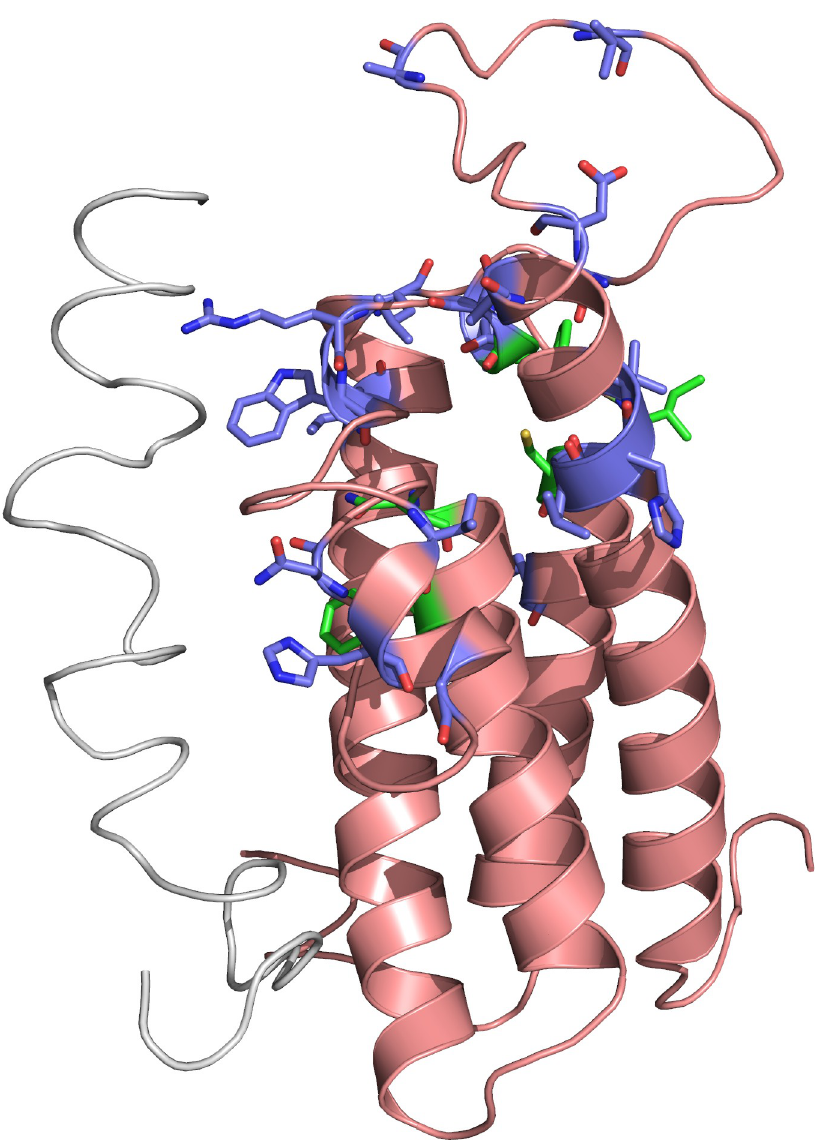
Fig 4. Locations of warfarin dosage affecting nonsynonymous variants in VKORC1. VKORC1 is shown in salmon, while ORF7a is shown in grey. Warfarin dosage affecting nonsynonymous variants are shown in blue. Active site amino acids are shown in